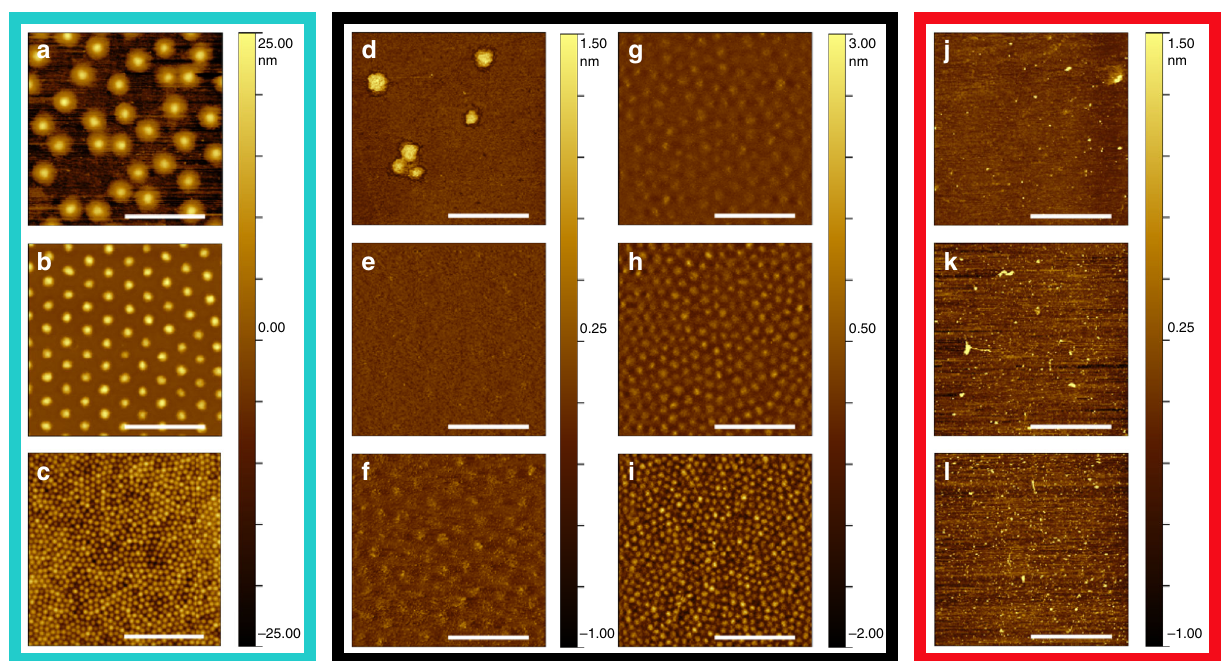
Fig. 4 Atomic force microscopy (AFM) micrographs of deposited monolayers on solid substrates. Series of AFM images in dry state corresponding to the positions a – l in Fig. 3 for 5 mol% crosslinked microgels (cyan box), ultra-low crosslinked (ULC) microgels (black box) and linear poly( N - isopropylacrylamide) (pNIPAM; red box) after deposition of the monolayer to a solid substrate at T = 20.0 ± 0.5 °C. Scale bars correspond to 2 μ